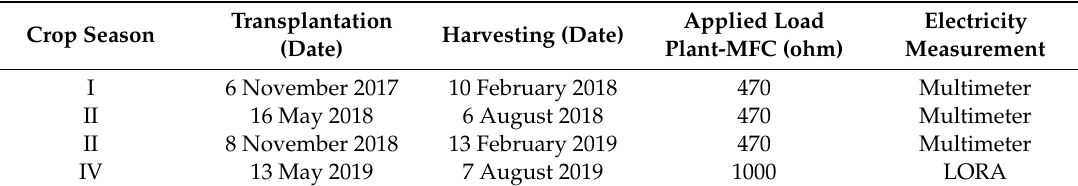
Table 1. Research phase on four different crop seasons.